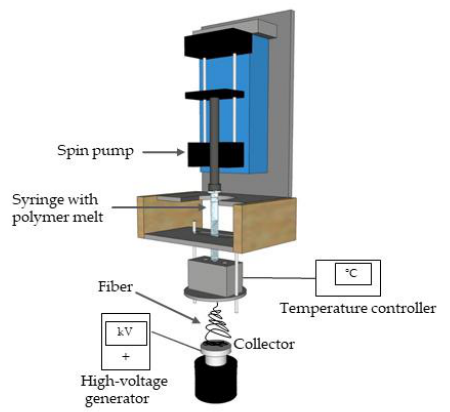
Figure 1. Schematic illustration of the laboratory-scale melt-electrospinning